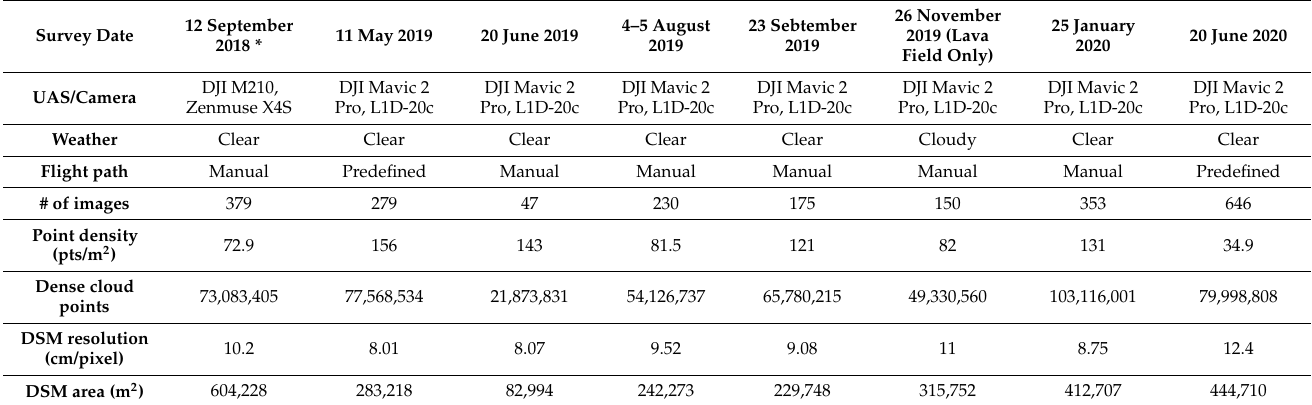
Table 1. Details of the photogrammetric surveys; * Point cloud from Carr